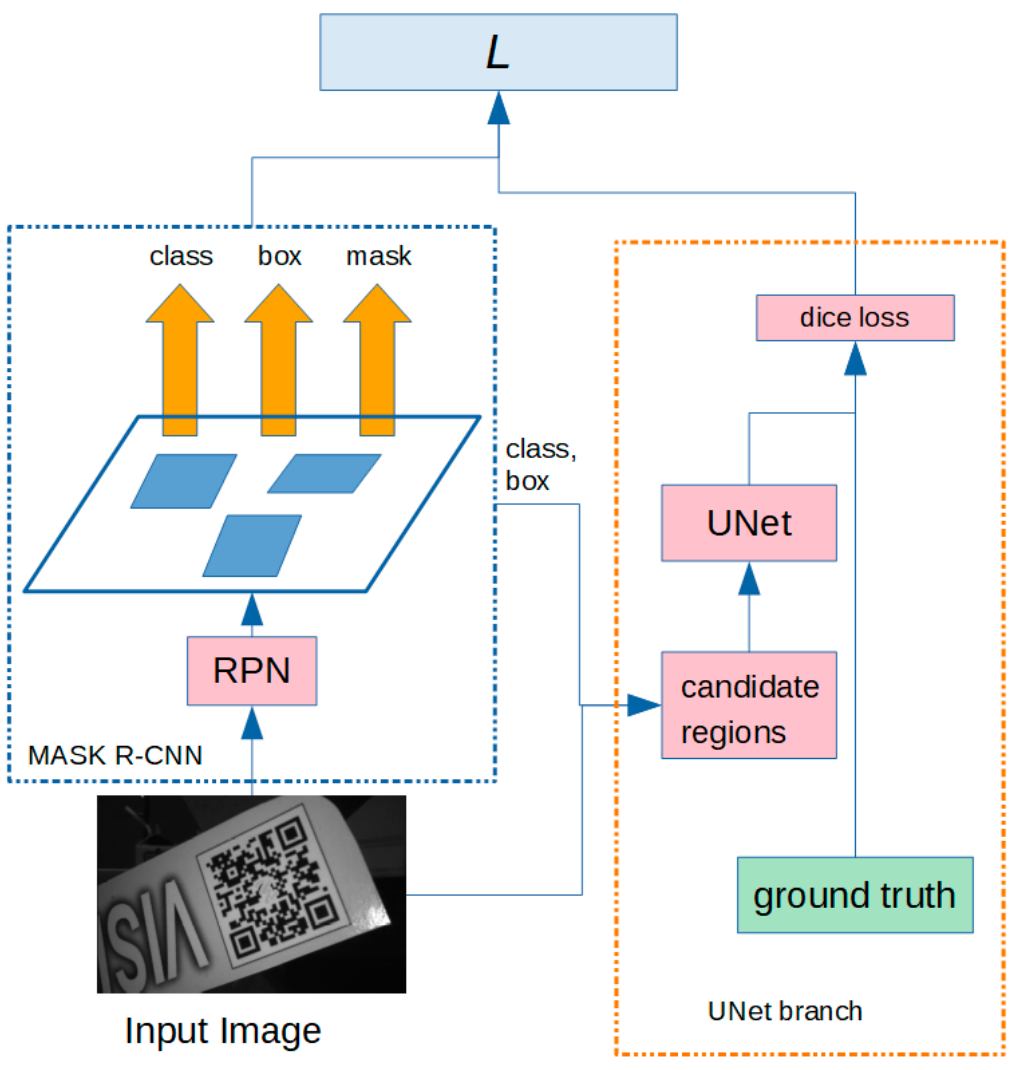
Figure 5. Network structure of MU R-CNN proposed in this paper.